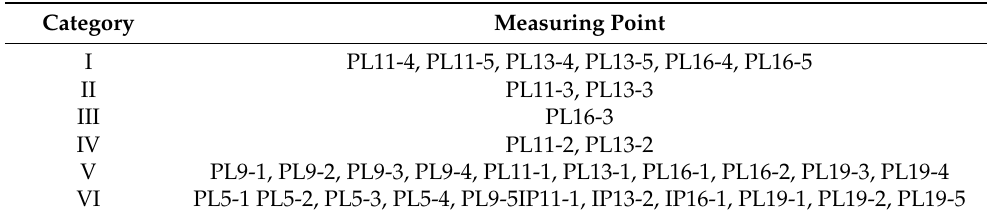
Table 2. Zoning results of deformation measuring points of the ultra-high arch dam during the second phase.